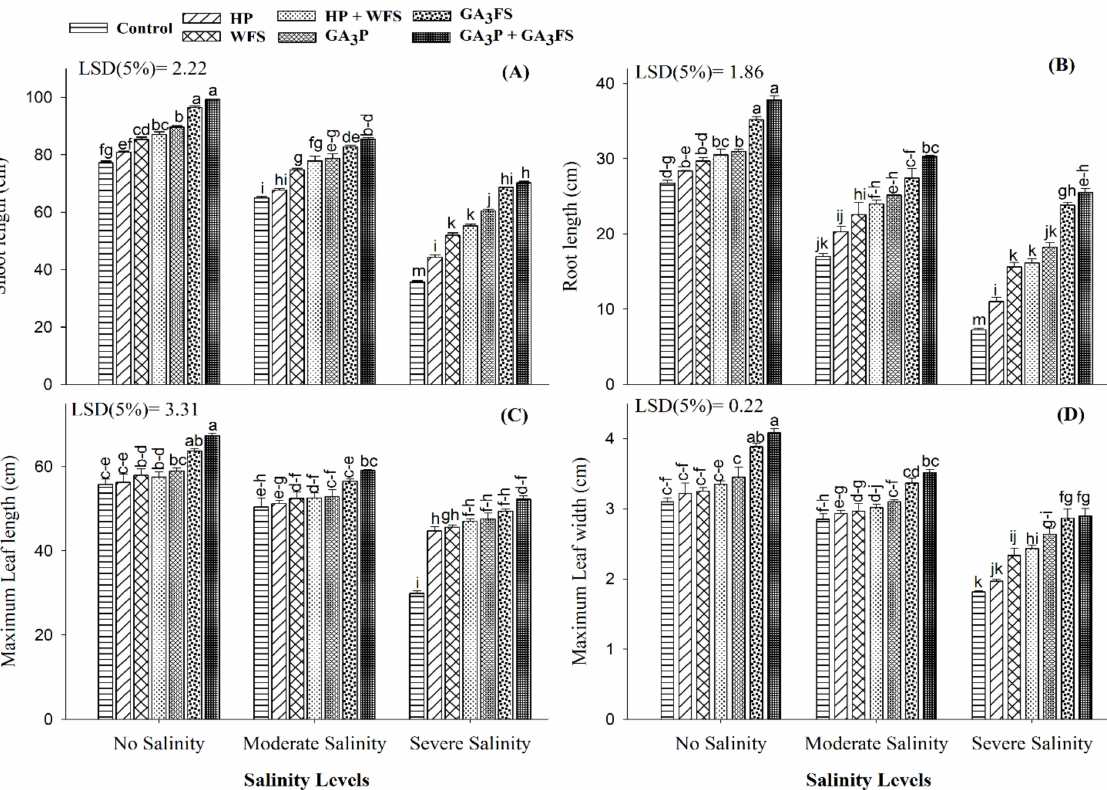
Figure 2. Shoot length ( A ), root length ( B ), maximum leaf length ( C ) and maximum leaf width ( D ) of maize as affected by different treatments of gibberellic acid under no salinity (control), moderate salinity (6 dS m − 1 ), and severe salinity (12 dS m − 1 ). Values are means ± SD (n = 3). Hydropriming (HP); water foliar spray (WFS); hydropriming and water foliar spray (HP + WFS); seed priming with GA 3 (GA 3 P); foliar spray with GA 3 (GA 3 FS); seed priming and foliar spray of GA 3 (GA 3 P + GA 3 FS). Bars with the same letters do not differ significantly at p ≤